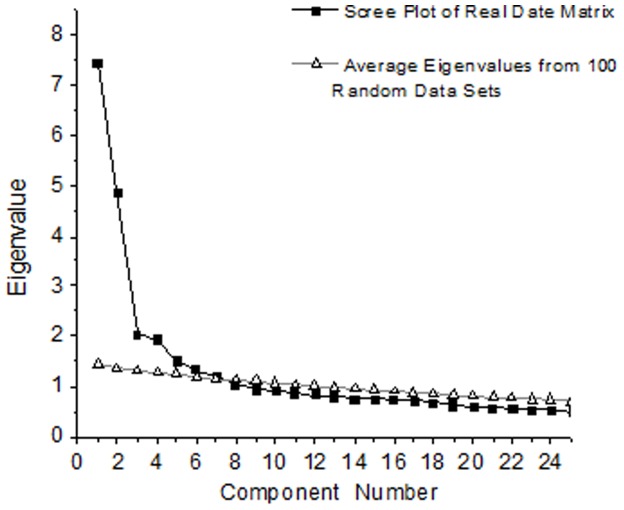
Parallel analysis plot (the first twenty-five factors).